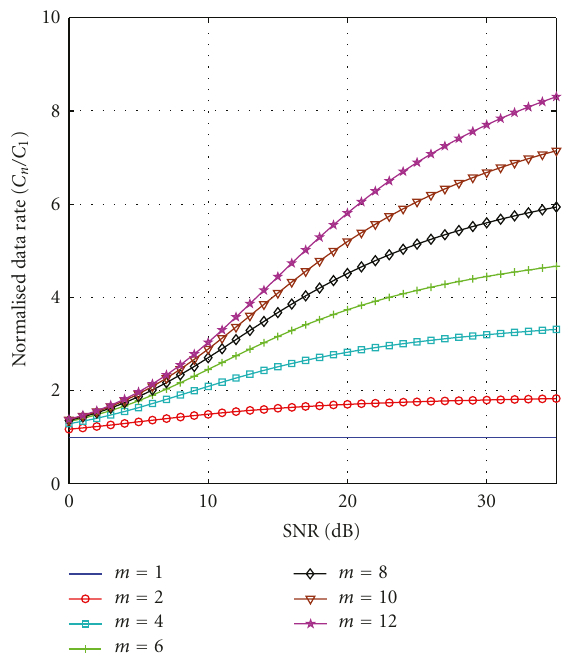
Figure 6: Data rate for m number of simultaneous bits normalized to the data rate of BPEM ( m =